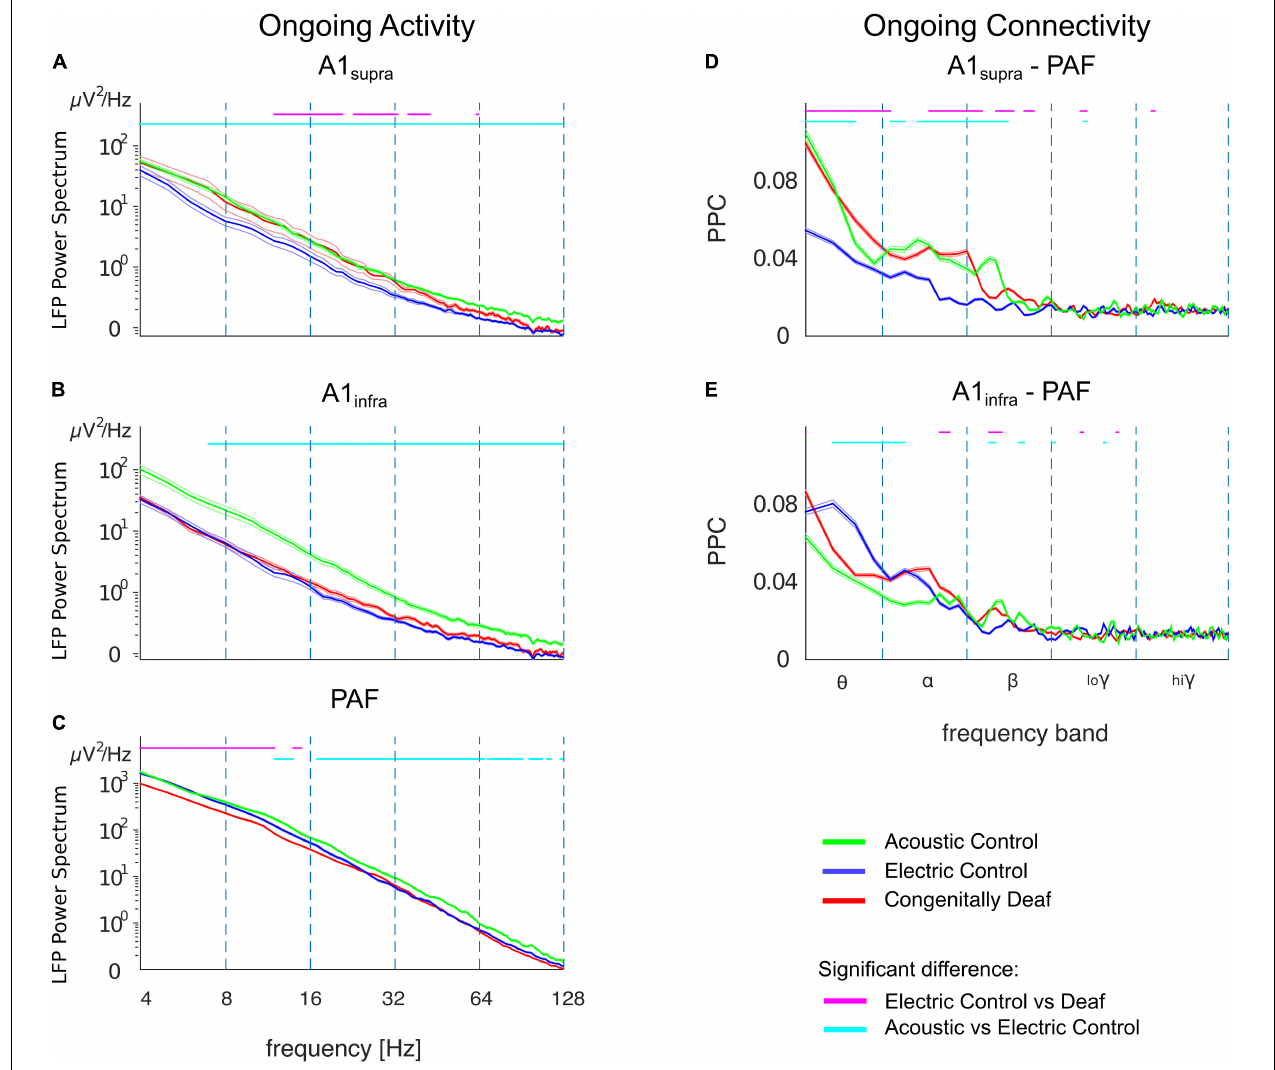
FIGURE 7 | Ongoing LFP power and functional connectivity in A1 and PAF in controls and congenitally deaf cats in absence of stimulation. (A) Average LFP power spectra in supragranular A1 (A1 supra ), comparison between acoustic controls with intact cochlea (ACs, green), electric controls with acutely deafened cochlea (ECs, blue), and congenitally deaf cats (CDCs, red) in absence of a stimulus. Data computed from bipolar derivation LFPs. Trials with bursting and spindles were removed before analysis (see section “Materials and Methods”). (B) Same as A for infragranular layers in A1 (A1 infra ). (C) Average LFP power-spectra in PAF computed from unipolar LFPs. Note the LFP power scale difference. (D) A1 supra – PAF functional connectivity in absence of stimulation, computed using pairwise phase consistency (PPC). (E) Same as D for A1 infra – PAF functional connectivity. (A–E) Shaded areas represent standard errors of the mean. Statistical pairwise comparisons are shown for electric control vs. deaf (magenta line above the graph) and animals with intact cochleae vs. acutely deafened cochleae (cyan line above the graph) using the two-tailed Wilcoxon rank-sum test (false discovery rate corrected, p <